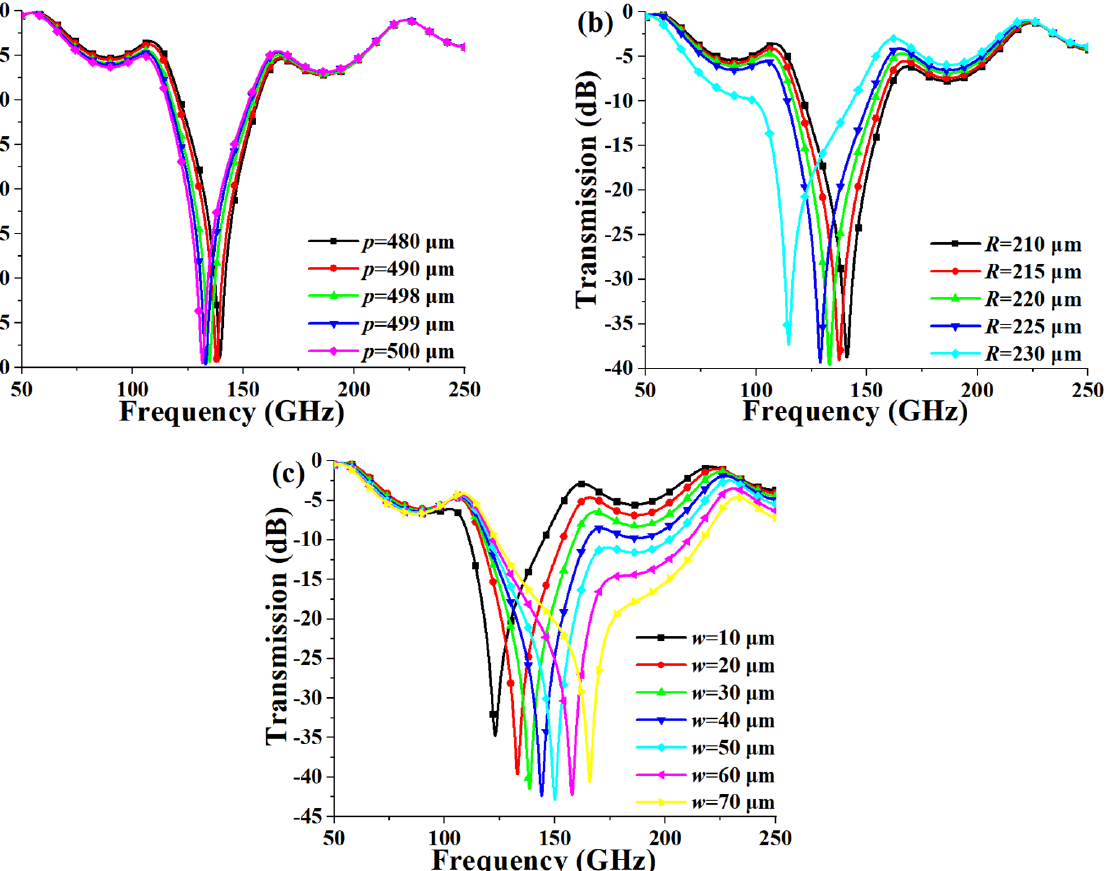
Figure 4. Influence of the structural parameters: ( a ) period p , ( b ) outer radius R , ( c ) width of the circular loop w on transmission response.